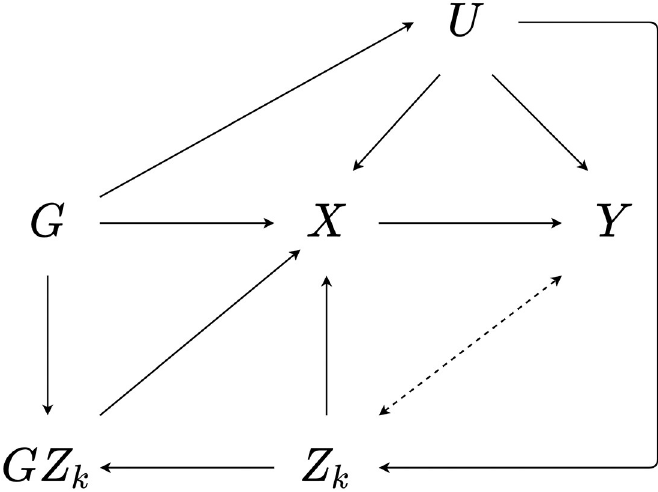
Fig 2. An example of GxE2 through confounding. A path diagram illustrating a case in which the instrument G i is a determinant of the interaction covariate Z represents an association induced due to confounding as a result of not adjusting for U in the second stage MR-GxE model.